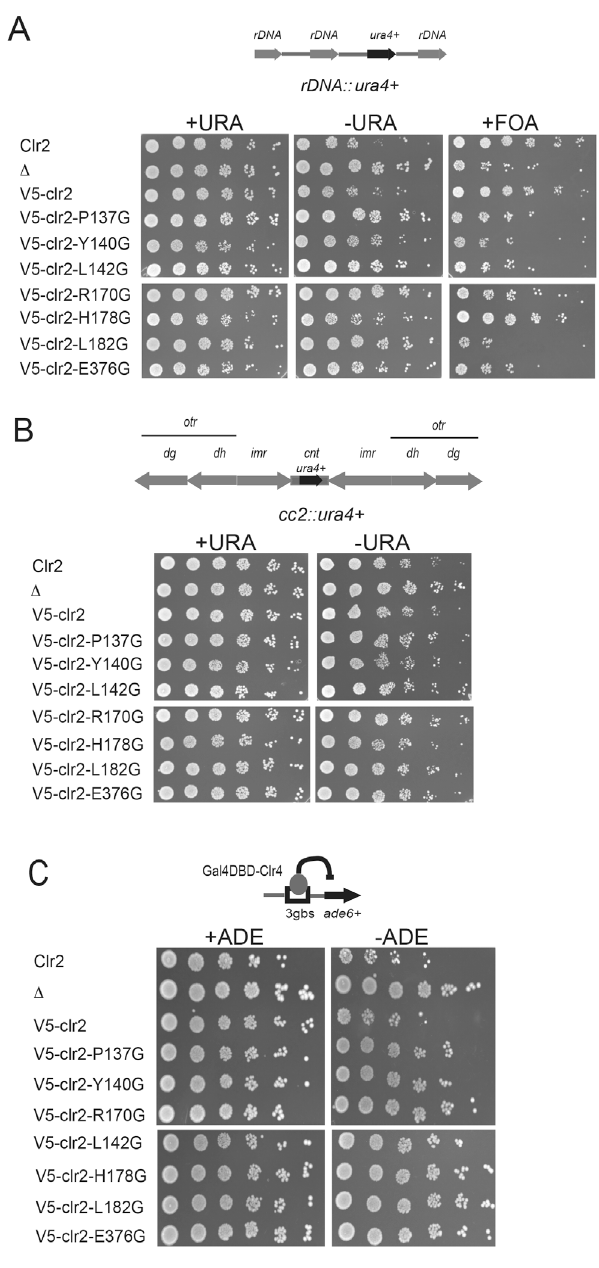
Figure 7. Point mutations in Clr2 affected transcriptional silencing at several locations in the S. pombe genome. Cells were diluted by a factor of 5 for each and spotted on + URA, selective – URA and counter-selective FOA plates. Top lane is the wild type strain (Clr2) that grows poorly on the –URA plates. Second lane is a strain lacking Clr2 ( D ), third contains the V5-Clr2 followed by the point mutations in Clr2; Clr2P137G, Clr2Y140G, Clr2L142G, Clr2R170G, Clr2H178G, Clr2L182G and Clr2E376G. The reporter gene is (A) rDNA:: ura4 + (B) cc2 ( Sph I):: ura4 + and in (C) the ade6 + reporter gene inserted into the ura4 locus and with Gal4DBD-Clr4 D CD resulting in repression of the ade6 + gene.